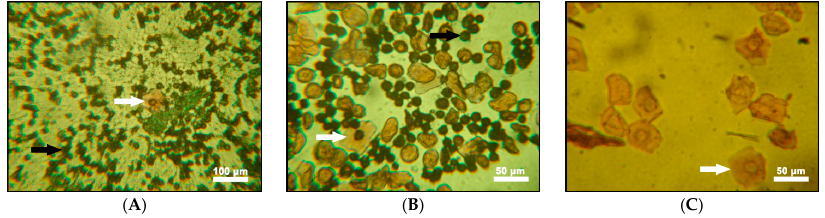
Figure 1. Vaginal swab samples stained with Pap. ( A ) Sample from a vaginal swab of a thyroidectomized female Wistar rat. Note the large number of lymphocytes (black arrow) characterizing the metestrus stage and rarely epithelial cells (white arrow); ( B ) A smear of a sample from an ovariectomized animal. In the diestrus stage, there is a large number of lymphocytes (black arrow) in addition to some epithelial cells (white arrow); and ( C ) In the proestrus control, the number of lymphocytes is very small or zero, with some identifiable epithelial cells (white arrow).